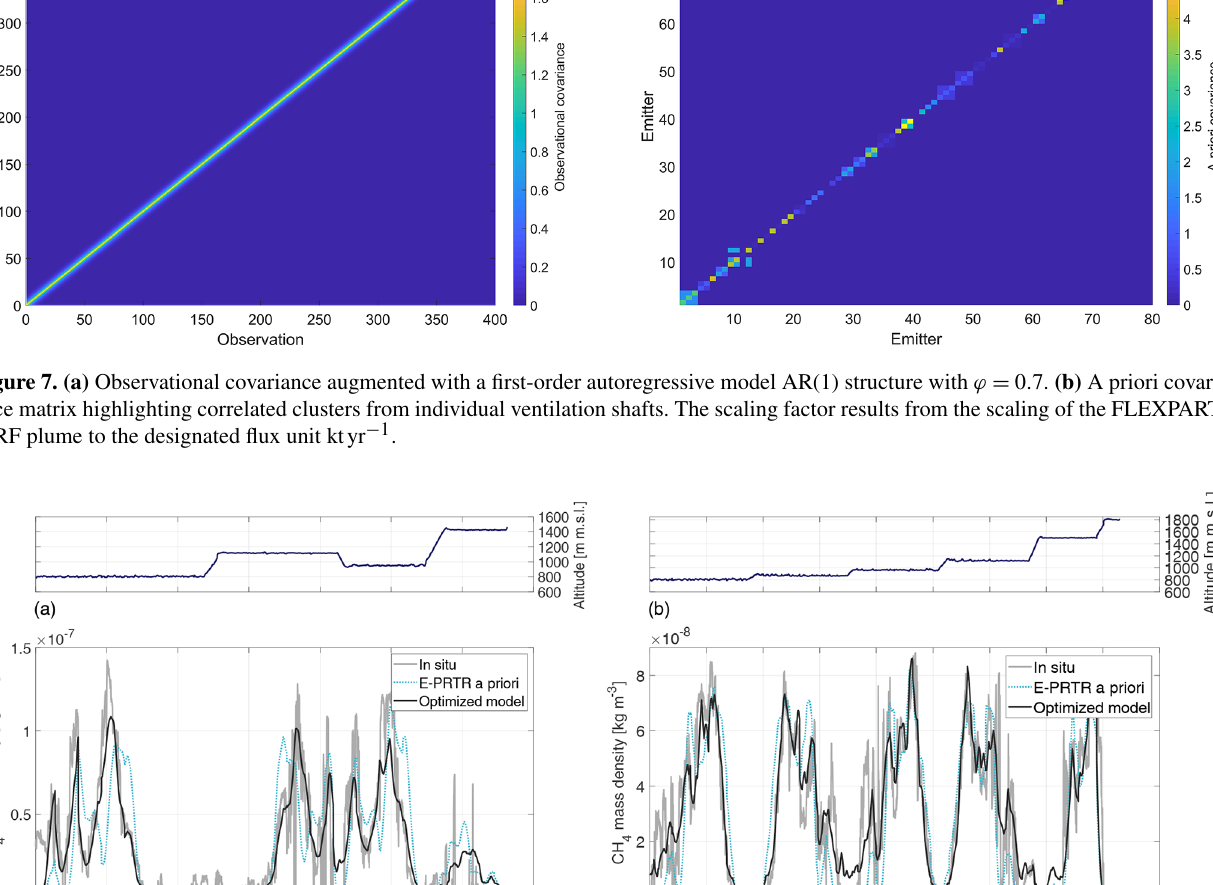
where m x denotes the total mass of the species of inter- est. The unitless coefficient m x m − 1 from the sensed CH 4 mole fractions c x in units of mol mol − 1